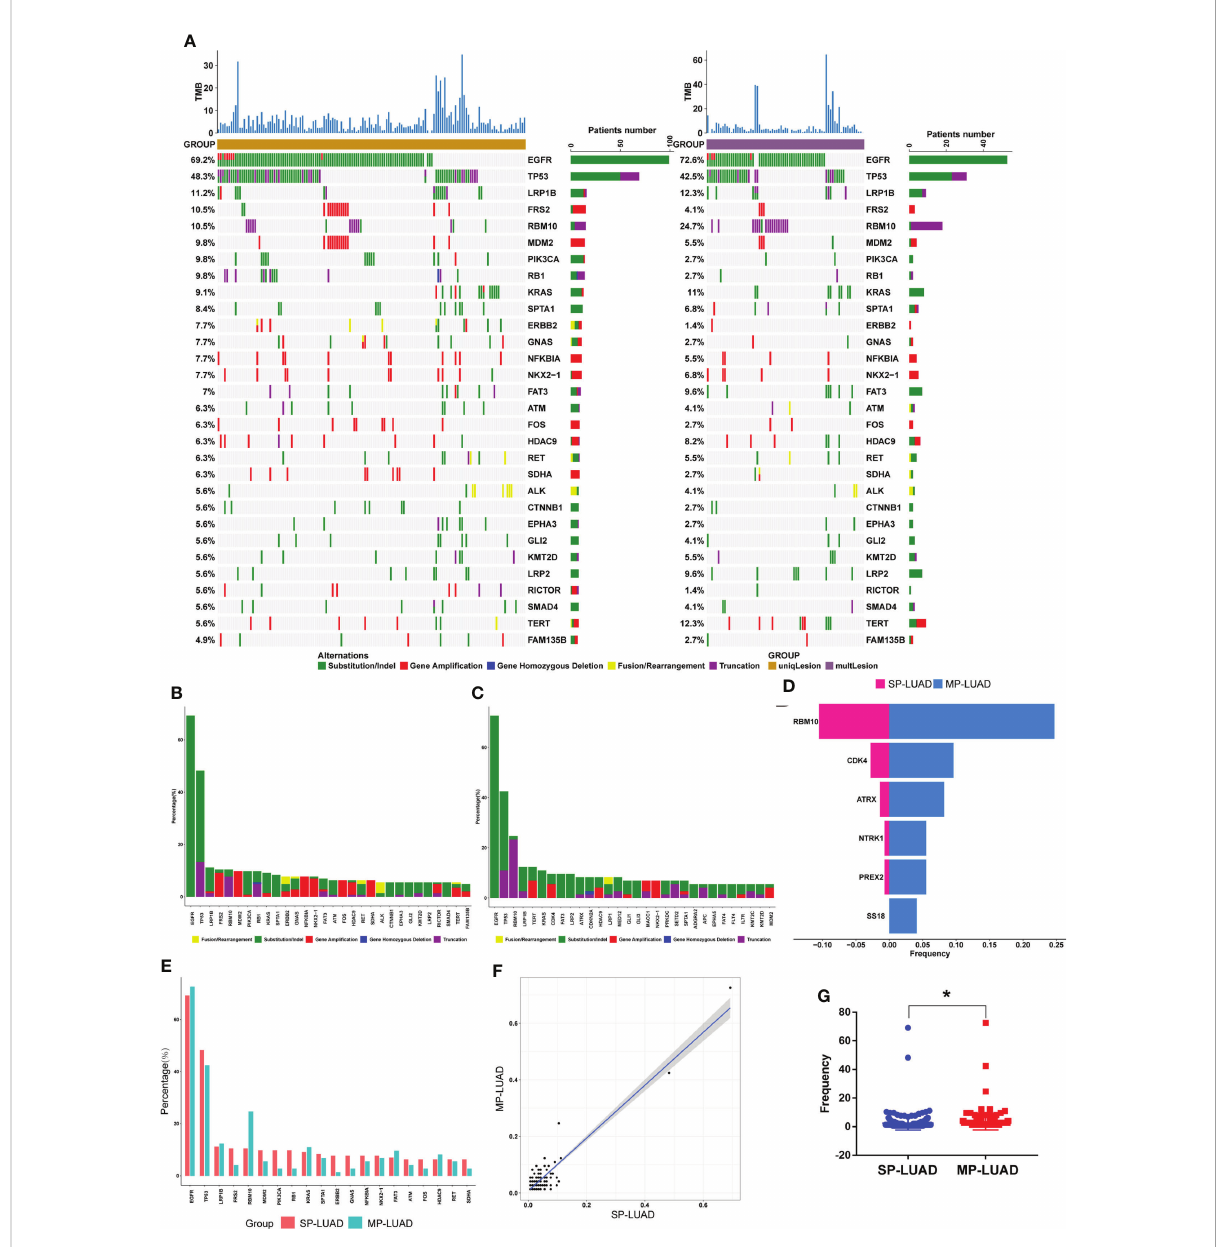
FIGURE 2 Comparation of SP- and MP-LUAD lesions. (A) The waterfall plot of tumor somatic mutation established based on the SP-LUAD (left) and MP- LUAD (right) cohort. (B, C, E) The difference of mutation frequency of common mutated genes between SP- and MP-LUAD lesions. (D) Six genes statistically different mutated among these two cohorts, including RBM10, CDK4, ATRX, NTRK1, PREX2, SS18. (F, G) Mutation Frequency of SP- and MP-LUAD lesions. *